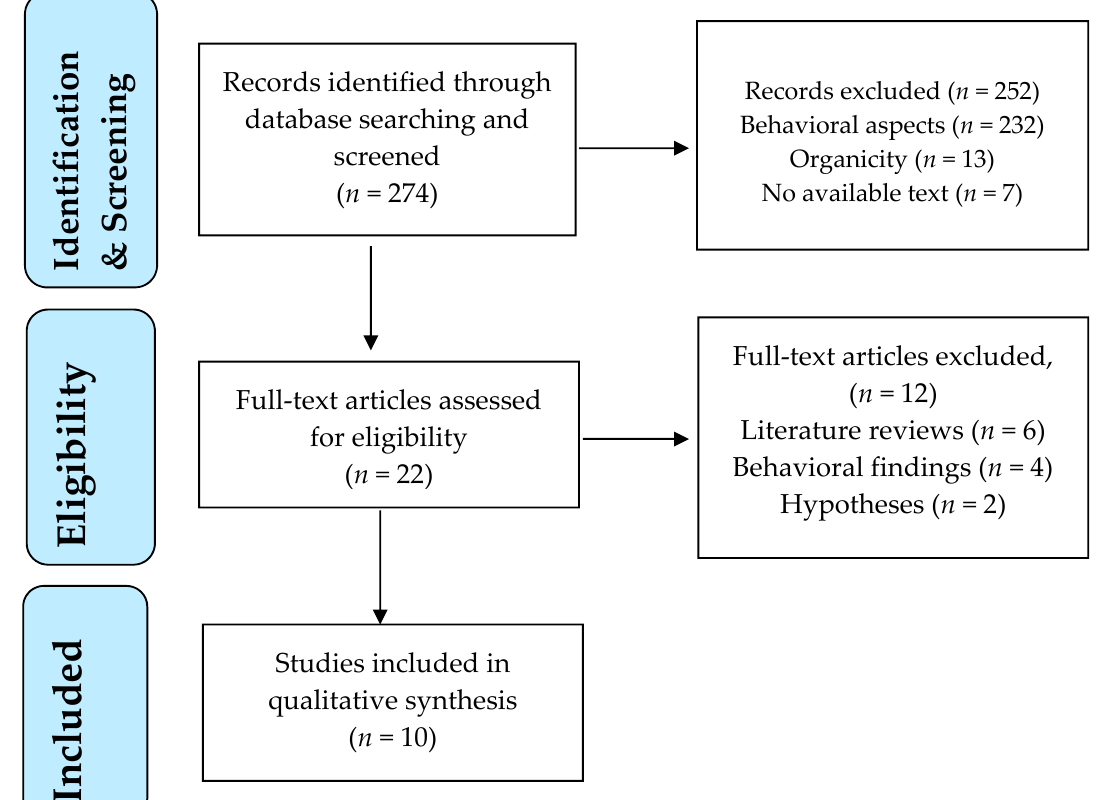
Figure 1. PRISMA flowchart of study selection process.